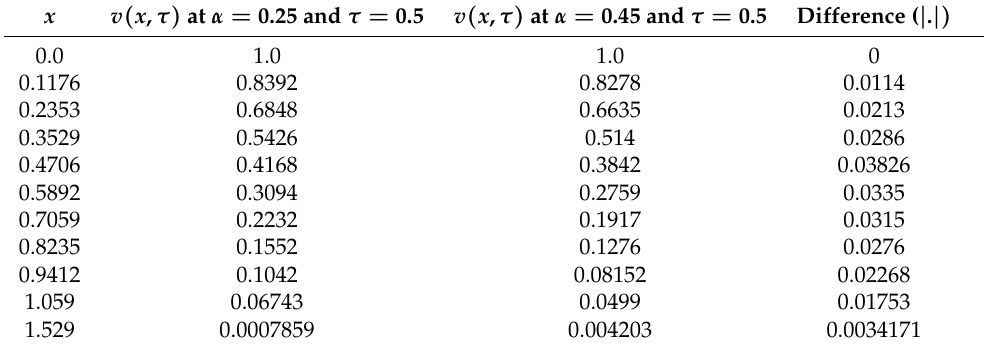
Table 1. Temperature profile with Pr = 1.